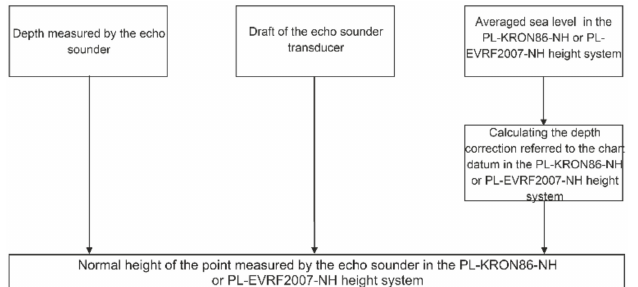
Figure 7. Flowchart showing steps of method for determining the depth in relation to a fixed reference